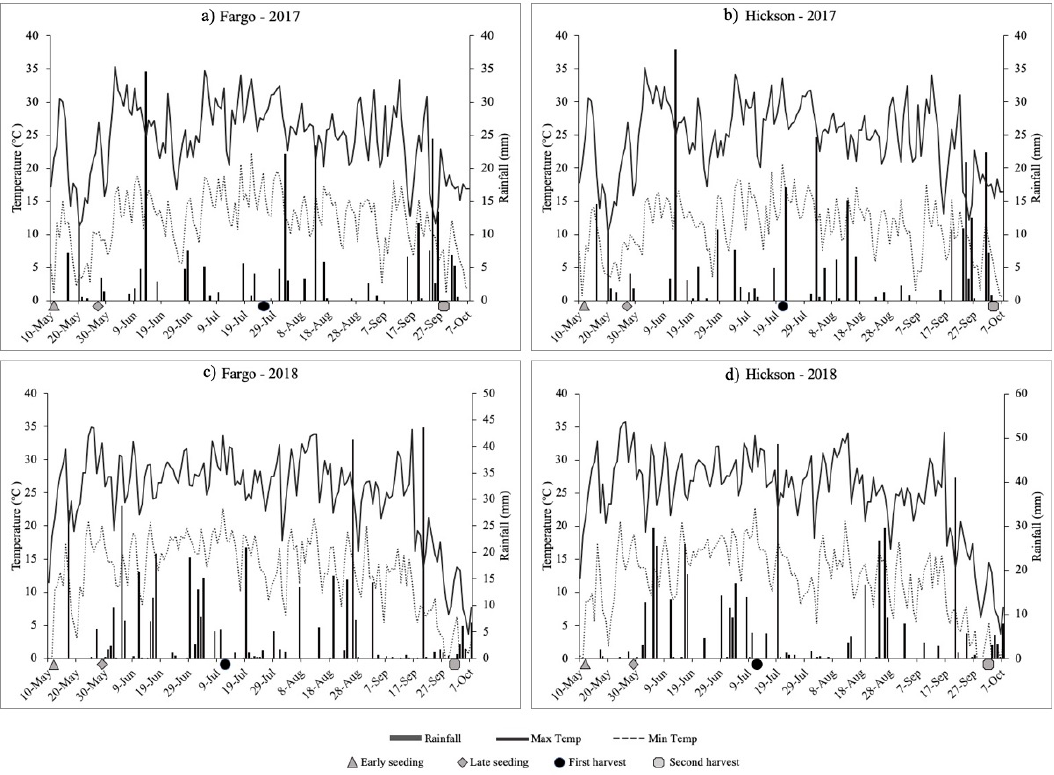
Figure 1. Air temperature and rainfall distribution (rainfall events indicated in grey bars) at four environments at ( a ) Fargo 2017, ( b ) Fargo 2018, ( c ) Hickson, 2017, and ( d ) Hickson 2018, ND, USA. Table 1. Soil analysis before seeding at Fargo and Hickson, ND, USA in 2017 and